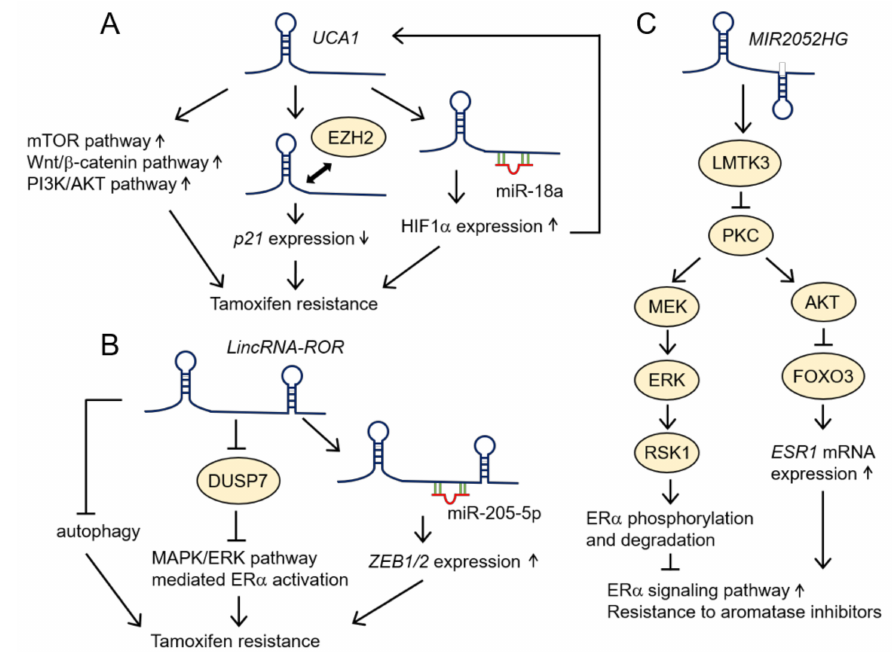
Figure 3. Schematic representation of the functions of UCA1 , lincRNA-ROR , and lncRNA MIR2052HG in the tamoxifen resistance of breast cancer. ( A ) UCA1 promotes the tamoxifen resistance by several mechanisms. UCA1 activates mTOR, Wnt / β -catenin, and PI3K / AKT signaling pathways to enhance tamoxifen resistance. In addition, UCA1 binds to EZH2 and epigenetically suppresses p21 expression. Moreover, UCA1 sponges miR-18 to upregulate HIF1 α expression. Since HIF1 α induces UCA1 expression, UCA1 and HIF1 α form a feedback regulatory loop to strengthen tamoxifen resistance. ( B ) LincRNA-ROR enhances tamoxifen resistance by inhibiting autophagy. Moreover, lincRNA-ROR induces the degradation of an ERK-specific phosphatase, DUSP7, resulting in ER α activation mediated by the MAPK / ERK signaling pathway. LincRNA-ROR also acts as a competing endogenous RNA (ceRNA), which sponges miR-205-5p to upregulate the expression of EMT-related genes ZEB1 / 2 and contributes to tamoxifen resistance. ( C ) MIR2052HG increases the expression of LMTK3. LMTK3 suppresses the activity of PKC, which increases the expression of ESR1 mRNA and ER α protein through the inactivation of AKT and MEK / ERK / RSK1 signaling pathway, respectively. UCA1 : urothelial cancer associated 1 ; lincRNA-ROR : large intergenic noncoding RNA-regulator of reprogramming ; MIR2052HG : miR2052 host gene ; mTOR: mammalian target of rapamycin; PI3K: phosphoinositide 3-kinase; EZH2: enhancer of zeste homolog 2; HIF1 α : hypoxia-inducible factor 1 α ; DUSP7: dual specificity phosphatase 7; MAPK / ERK: mitogen-activated protein kinase (MAPK) / extracellular signal-regulated kinase (ERK); ZEB1 / 2 : zinc finger E-box binding homeobox 1 / 2 ; LMTK3: lemur tyrosine kinase 3; PKC: protein kinase C; ESR1 : estrogen receptor 1 ; MEK: MAPK / ERK kinase; RSK1: ribosomal S6 kinase